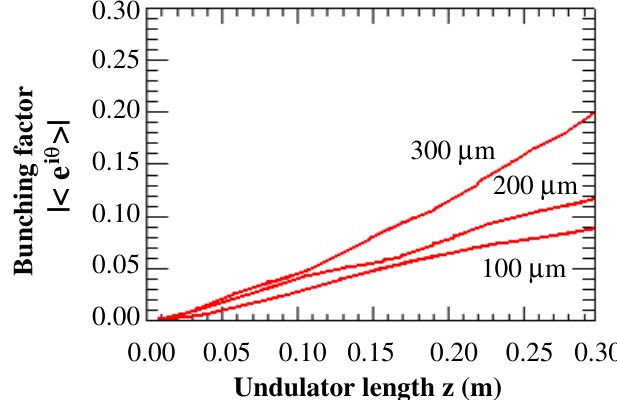
FIG. 5. (Color) Bunching factor of an electron beam copropa- gating with a 3 MW seed pulse with various wavelengths 100, 200, and 300 (cid:1) m in a 30 cm long